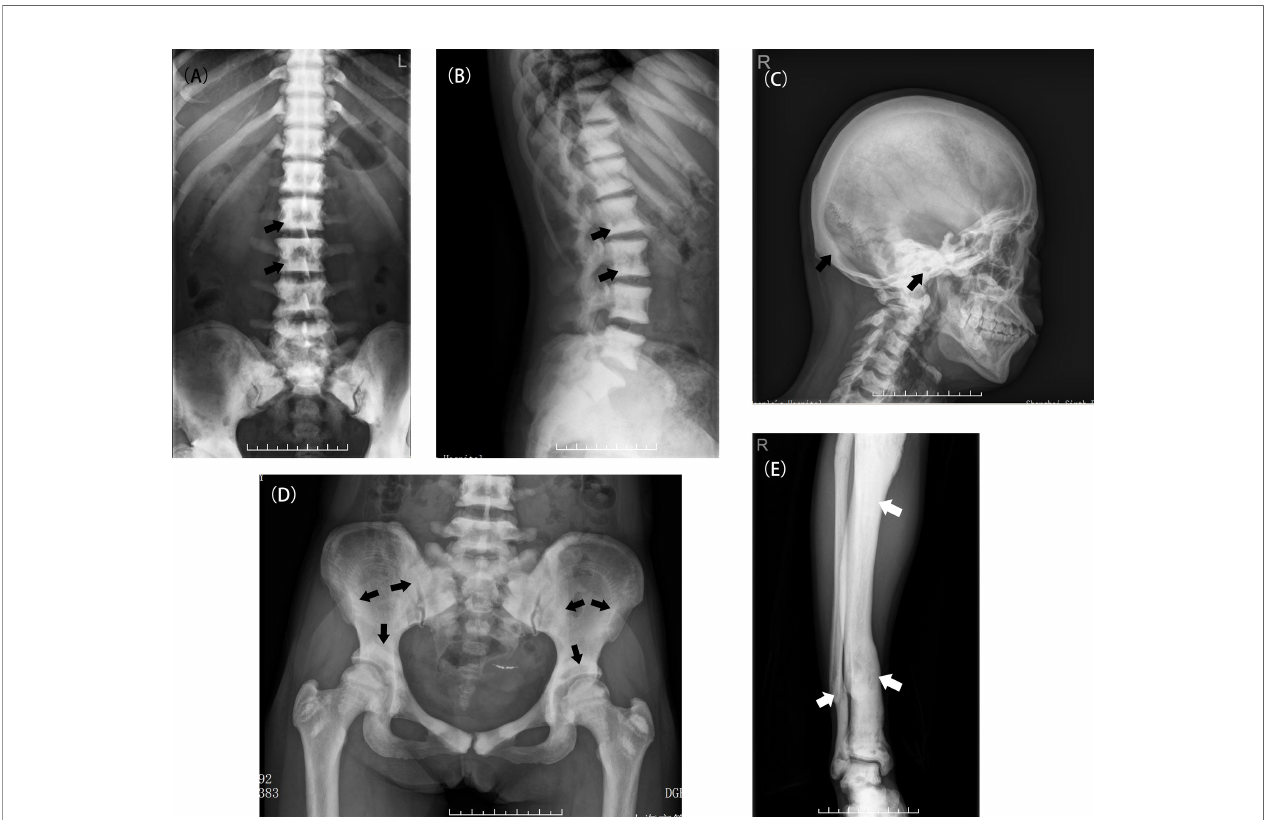
TABLE 2 | Sites, treatment and healing of patients ’ fracture. Patient Site Treatment Heal P1 Left femoral neck Total hip arthroplasty / P2 Right radioulna (3 times), right tibio fi bula Conservative treatment Healed P3 Right humerus NA NA P4 Right dorsum of foot Conservative treatment Healed P7 Right clavicle, left femoral neck NA Healed P10 Left tibia, radius Conservative treatment Healed P14 Left proximal femur, left femoral shaft Internal fi xation Non-healed P15 Right radius, right little fi nger, bilateral radioulna (2 times) Conservative treatment Healed P16 NA NA NA P17 Left femur (2 times), right femur NA Healed P18 Left distal radius Conservative treatment Healed P20 Right femur Internal fi xation Non-healed P21 Left tibia Conservative treatment Healed P25 Right tibia, right ankle, right middle fi nger, right radioulna NA NA P27 NA NA NA P28 Wrist Conservative treatment Healed P29 Clavicle fracture NA NA P31 Right twelfth rib, proximal phalanx, right proximal femur, left femur (total 9 times) NA NA P34 Left elbow joint, left ankle, right ankle, coccygeal vertebra Conservative treatment Healed P35 Rib Conservative treatment Healed NA, Not